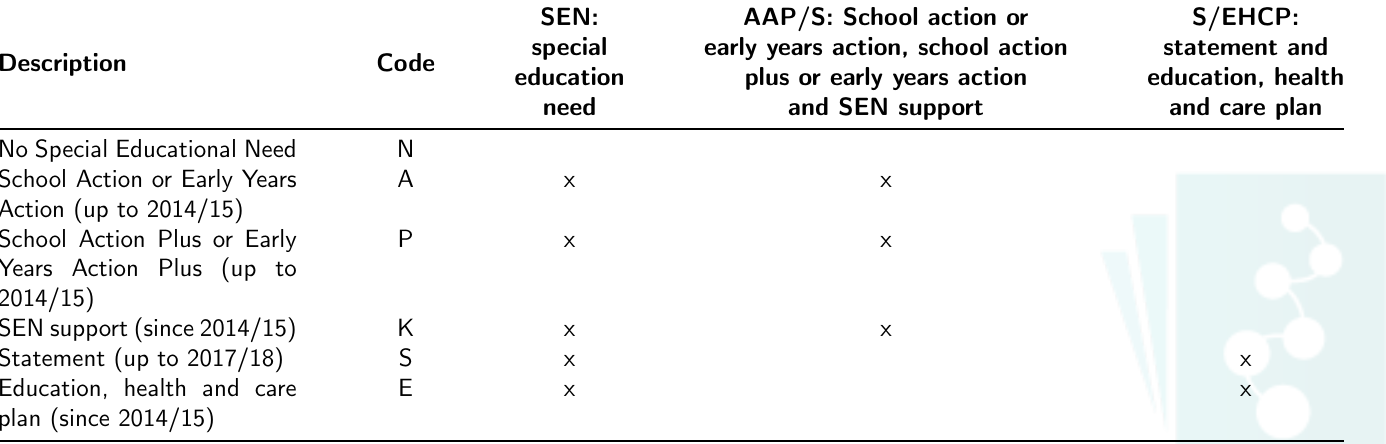
Supplementary Table 4.3: Classification of SEN, AAP/S and S/EHCP